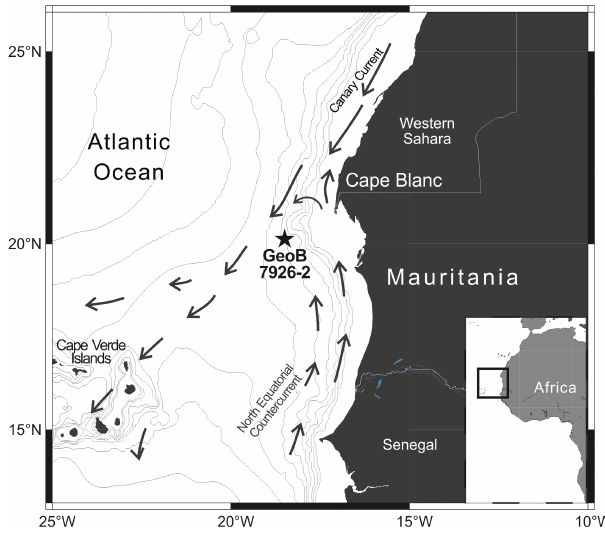
Figure 1. Locality of gravity core GeoB7926-2 (black star) in the low-latitude NE Atlantic upwelling area. Arrows indicate the major oceanic currents in the study area. Inset: location of the study area off coastal NW Africa. Modified after Romero et al.